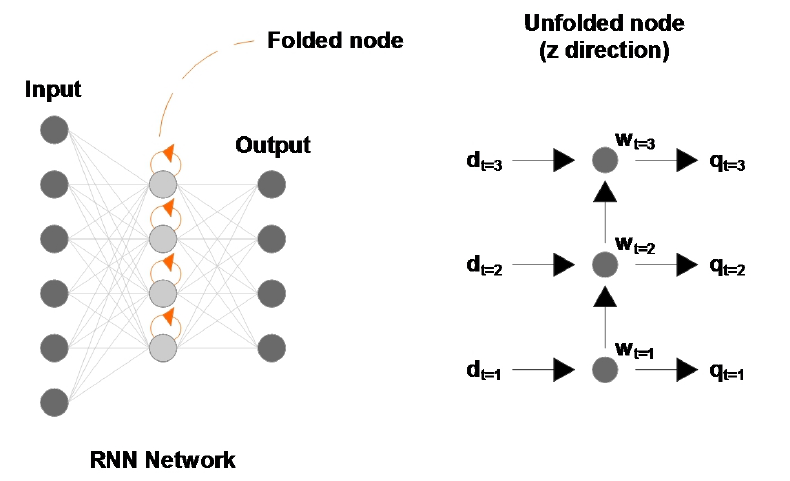
Figure 1. Recurrent neural